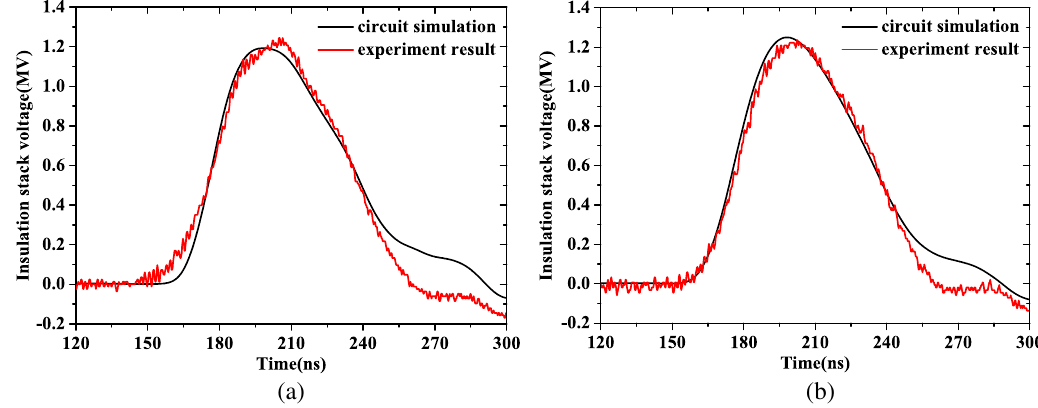
FIG. 13. Comparison of the simulation (black solid line) and experiment results (red solid line) of the insulation stack voltage waveforms at (a) 30 degrees and (b) 90 degrees. The calculated voltage waveforms are in agreement with the measurement results over most of the pulse duration.